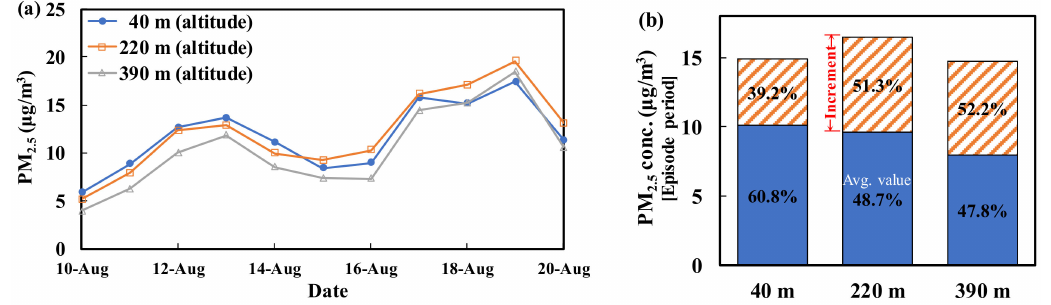
Figure 9. Mean PM 2.5 concentrations measured at different altitudes at Taipei 101 during 10—20 August. ( a ) Daily mean, ( b ) Incremental